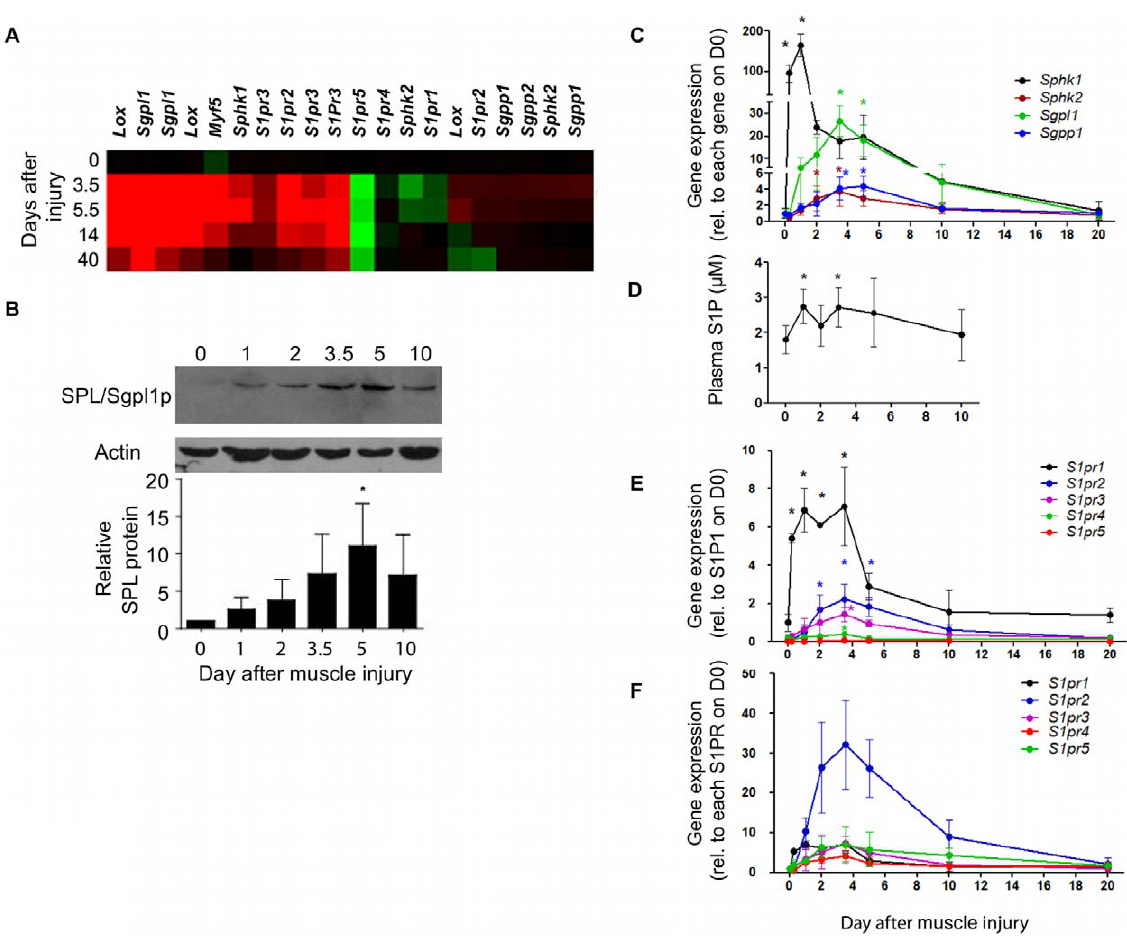
Figure 1. Dynamic changes in S1P signaling after muscle injury. A) Heat map of S1P receptors, S1P metabolic genes and other markers in WT C57BL/6 mouse skeletal muscle from day 0–40 after NTX injection. Red is induced, green is repressed relative to the mean. Note: two probes were available for some genes. Lox =lysyl oxidase; S1pr1–5 =S1PRs; Sgpl1 =SPL. Sgpp =S1P phosphatases; Sphk =sphingosine kinases. B) SPL protein (Sgpl1p) expression is induced after muscle injury, as determined by immunoblotting (above) and imageJ quantification relative to day 0 (uninjured muscle) and normalized to actin (below). C) Relative gene expression of Sphk1, Sphk2, Sgpl1 and Sgpp1 (normalized to Gapdh ) were evaluated in whole muscle over time after injury by qRT-PCR. Gene levels are depicted relative to their own baseline levels (day 0 set as 1 for all genes). D) Corresponding plasma S1P levels were measured by LC-MS, E) Relative gene expression of S1PRs was determined as in ‘‘C’’ and is depicted relative to S1pr1 (day 0 set as 1 for S1pr1 only). F) S1PR induction is shown relative to baseline levels for each receptor (day 0 set as 1 for all genes). * indicates significant difference compared to day 0, p # 0.05. Data are means 6 SD; n=3–5/group.